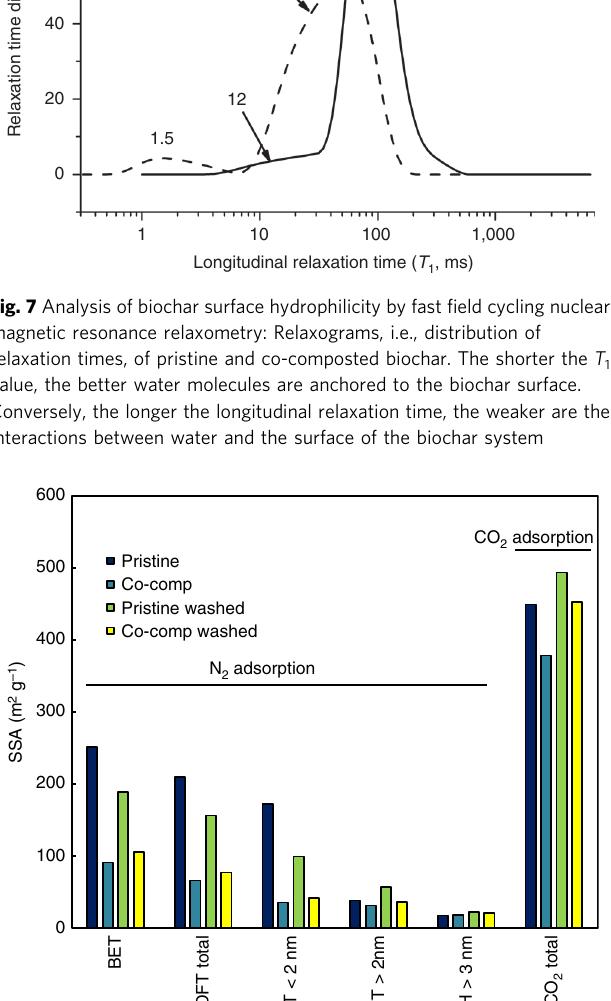
(Fig. 8, Supplementary Fig. 13 and Supplementary Discussion).